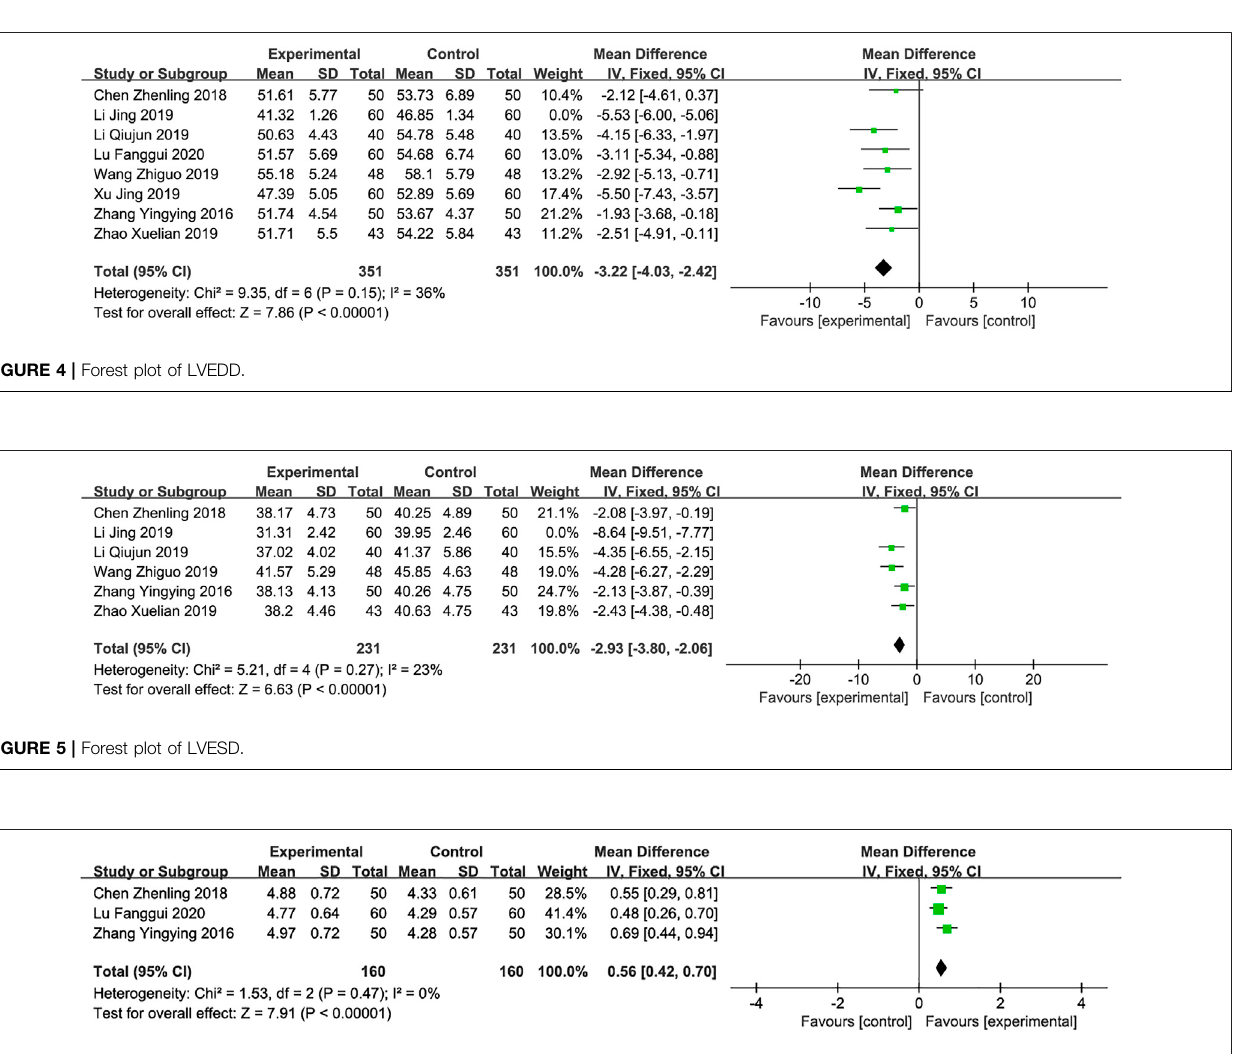
FIGURE 6 | Forest plot of cardiac